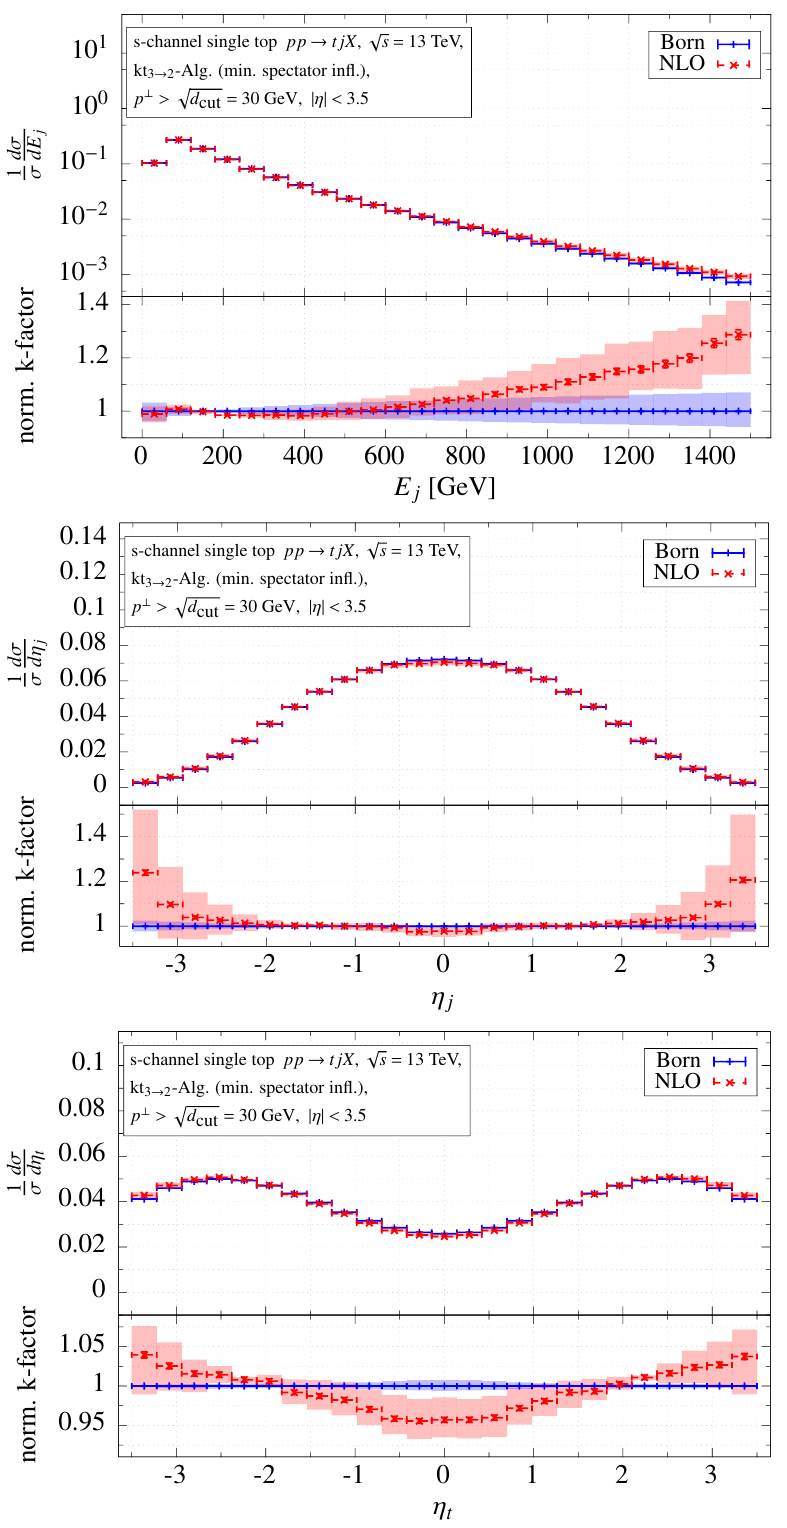
Figure 11 . Same as (cid:12)gure 9 but for the inclusive event de(cid:12)nition.